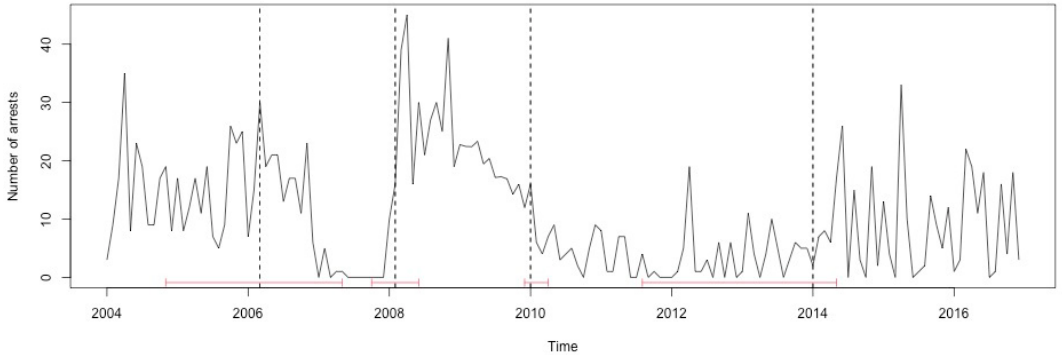
Figure A36. Methamphetamine-related organized crime arrests 2004–2016 in the Czech Republic and structural breaks.